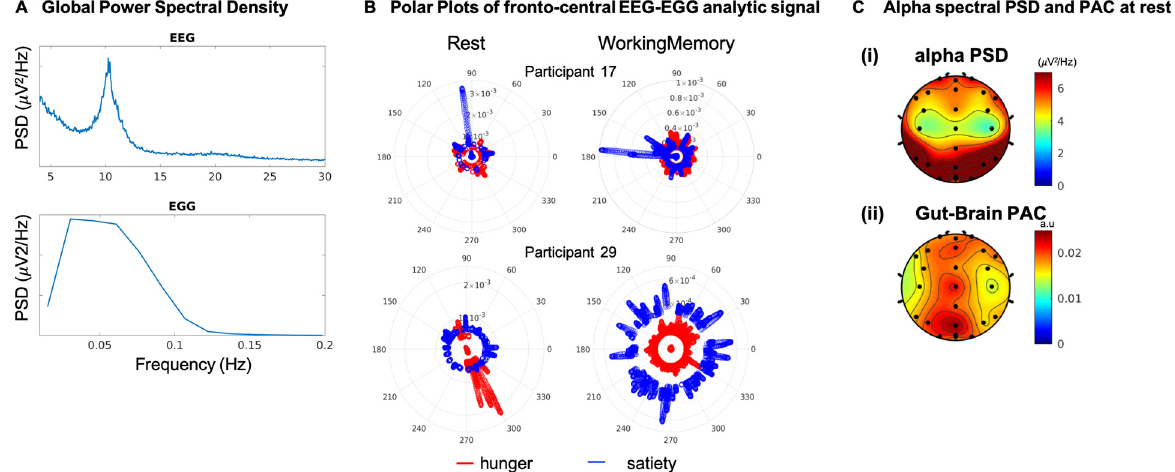
Figure 3. Procedure schematic. ( A ) Global power spectral density (PSD) across all participant data showed a dominant EEG rhythm peaking in the alpha band (9–14 Hz) and dominant EGG rhythm peaking in the 0.03–0.07 Hz range. ( B ) Phase and normalized magnitude of the EEG-EGG analytical signal shown as polar plots (see Methods Figure 2) for two exemplar participants in the left fronto-central brain region (F3, C3), these participants data suggest diversity in brain-gut coupling across conditions (levels of satiety, cognition) at the level of individual participants. ( C ) The top plot (i) represents the normalized alpha band PSD in uV2/Hz. The bottom plot (ii) represents normalized and log-transformed PAC showing midline areas with elevated PAC. All signals survived FDR statistical corrections for multiple comparisons across electrodes. PAC: phase amplitude